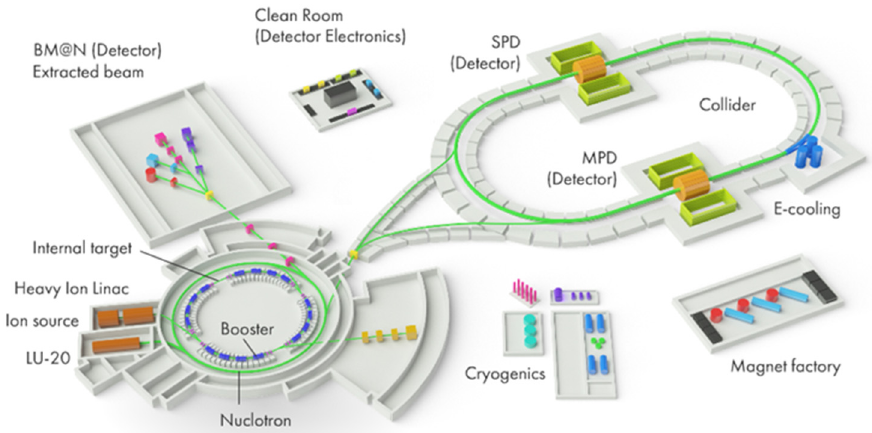
Figure 11. Layout of the NICA facility at JINR in Dubna (see text) [48].